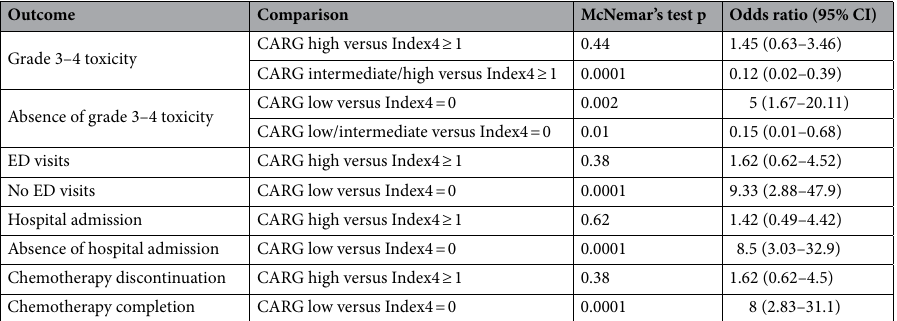
Table 8. Comparison of CARG with Index4. Odds ratios (ORs) below 1 favor CARG and ORs above 1 favor Index4. CI confidence interval. ED Emergency Department.